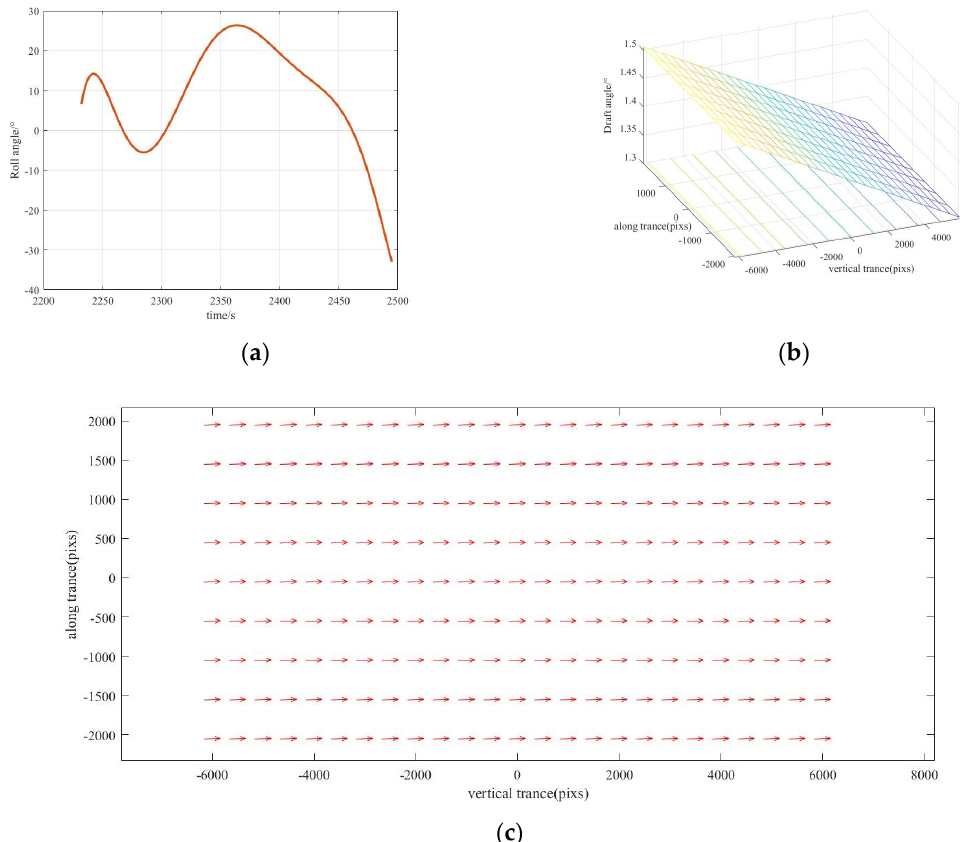
Figure 4. Roll angel and velocity vector: ( a ) The curve of roll angle; ( b ) The value of drift angles at 2367 s; ( c ) the distribution of velocity vectors on the image plane at 2367 s.